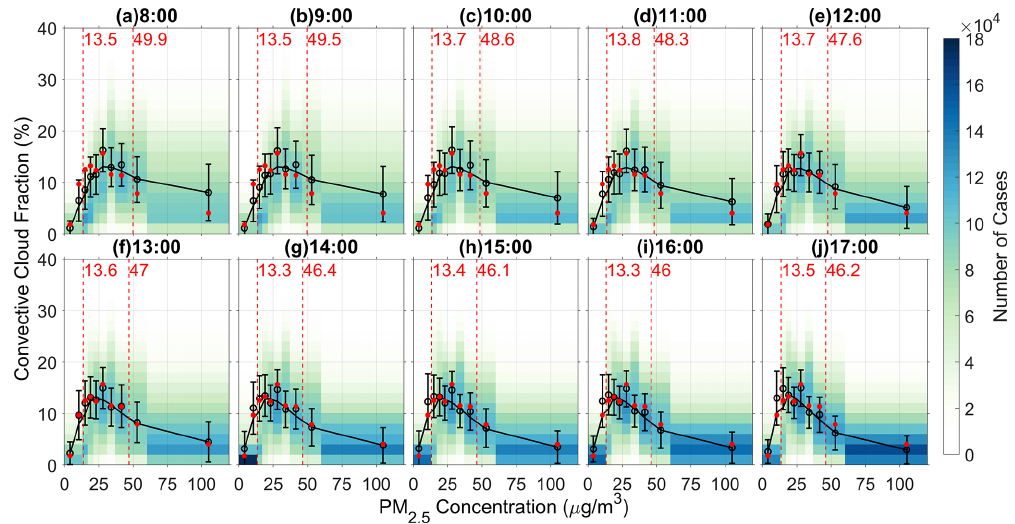
Figure 8. Convective cloud fraction with respect to PM 2 . 5 concentration at different times of day during May–September 2016/17. Color shading indicates the number of cases corresponding to each specific convective cloud fraction (CCF) and PM 2 . 5 bin. Note that PM 2 . 5 is separated into 10 equal-sample bins. Black circles and error bars are the mean values and SDs of CCF in each PM 2 . 5 bin within each hour, red dots indicate the mean CCF over all times. Solid black lines represent the three-point moving average of the black circles. Dashed red lines (with red numbers) mark the mean polluted and clean thresholds during each